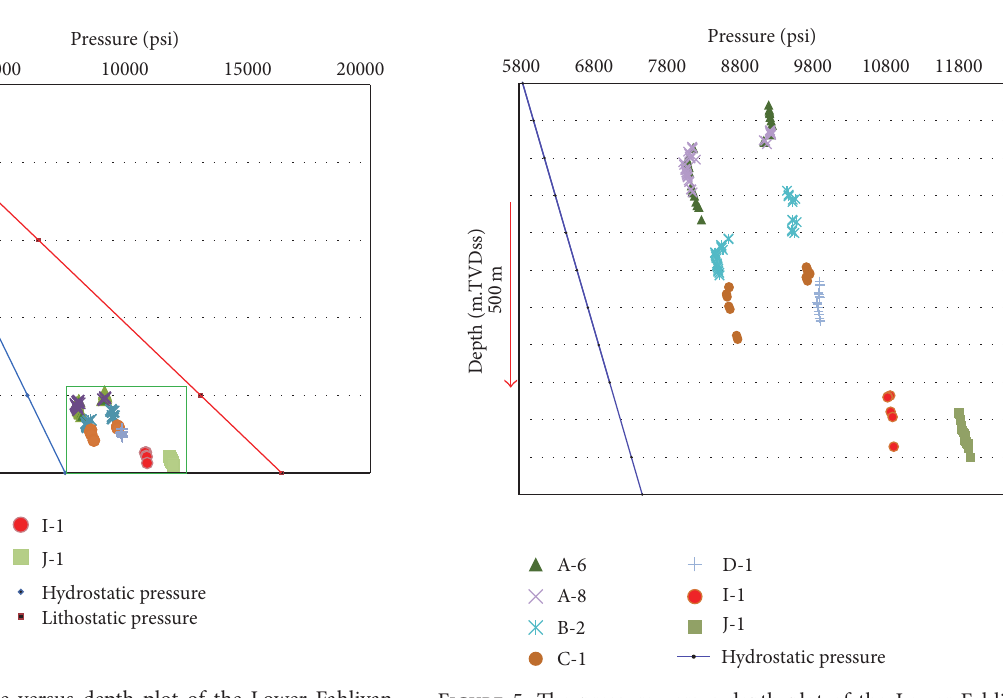
Figure 5: The pressure versus depth plot of the Lower Fahliyan reservoir from six different fields, zoomed in from Figure 4, show- ing a multilayered stacked reservoir with different pressures. The reservoir pressure decreases downward in a step-wise pattern. Also, the main pressure step can be seen clearly in wells A-6, A-8 (field A), B-2 (field B), and C-1 (field C) but not in wells D-1 (field D), I-1 (field I), and J-1 (field J) due to facies change of Fahliyan to Garau. The main pressure step suggests the presence of a regional efficient seal dividing the Lower Fahliyan reservoir into two stacked compartments. The pressure trend of the sublayers of each compartment in different fields shows more or less a similar trend. The hydrostatic pressure (blue line) has been attached as a reference